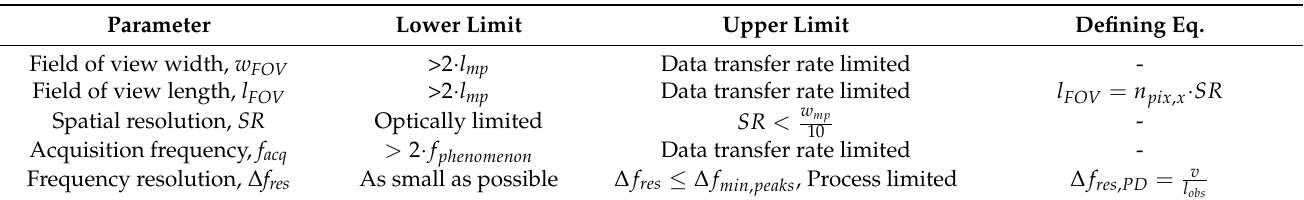
Table 1. Design cues for the design of a coaxial monitoring system to determine the surface geometri- cal parameters and the oscillations of the melt pool during the LPBF process.